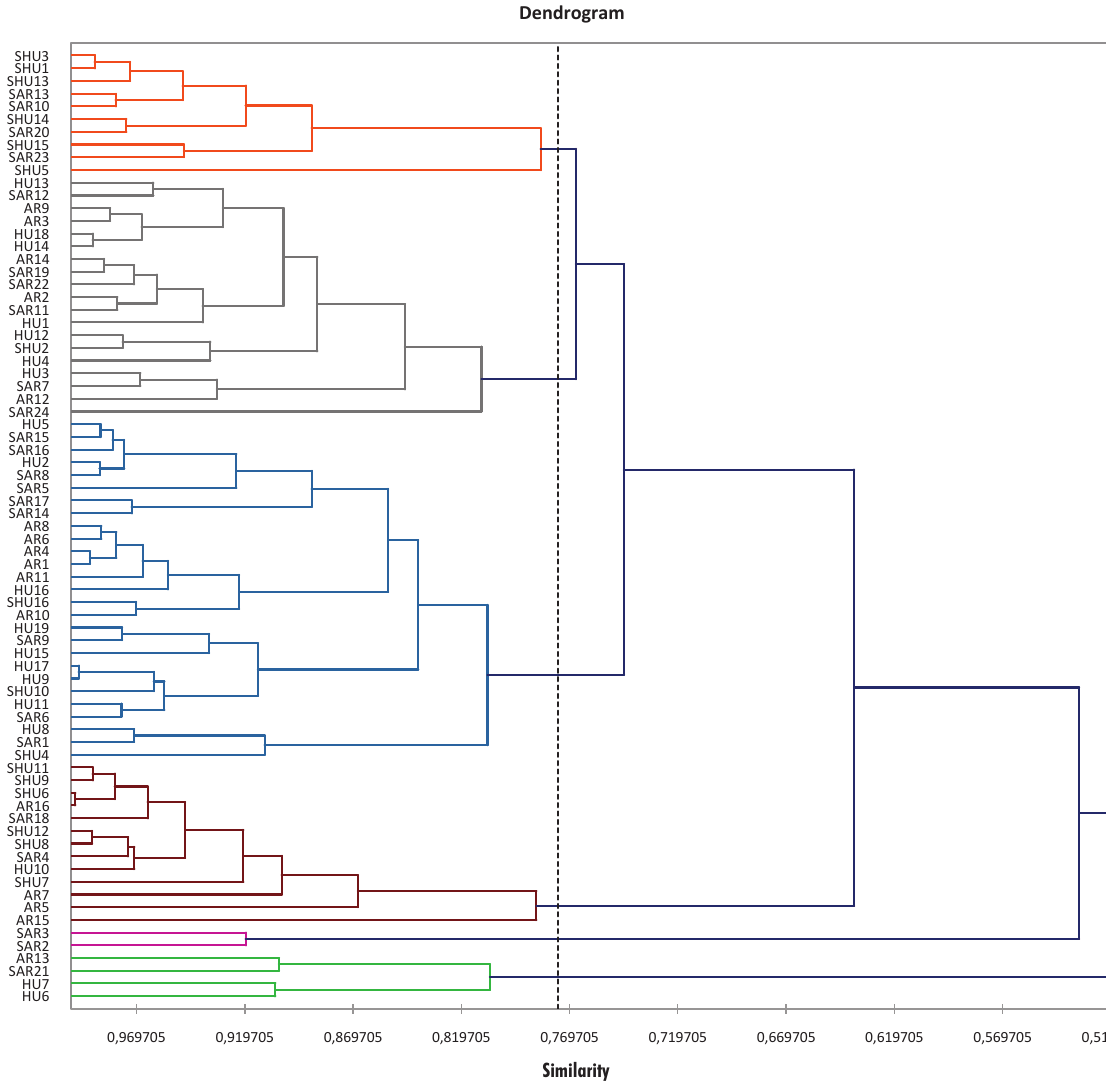
Fig. 2. Dendrogram showing similarity and successive clustering of 75 isolates of Mycosphaerella pinodes based on their aggressiveness in seven cultivars.